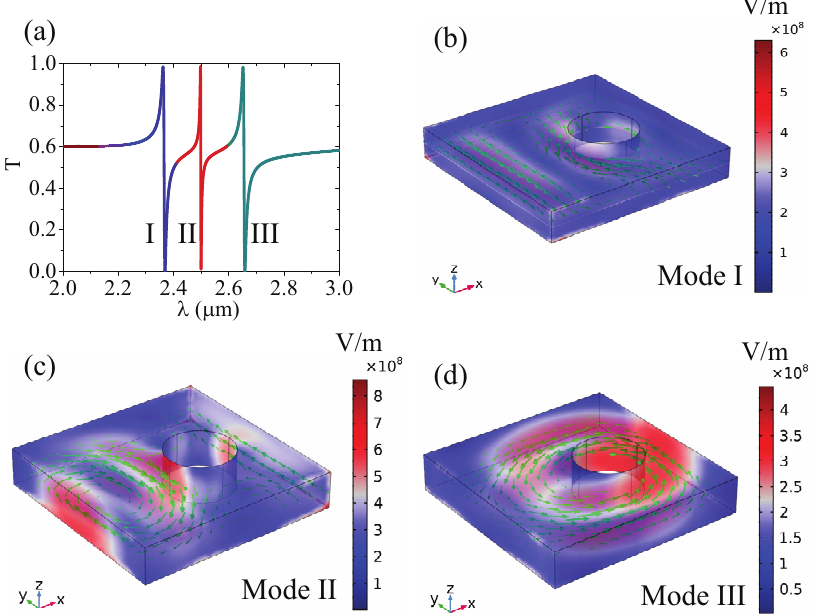
Figure 3. ( a ) Simulated transmission spectra; ( b – d ) electric field distribution at the resonant wave- length of modes I, II, and III. Green arrows in x − y plane represent the field direction, and the color scale corresponds to the field